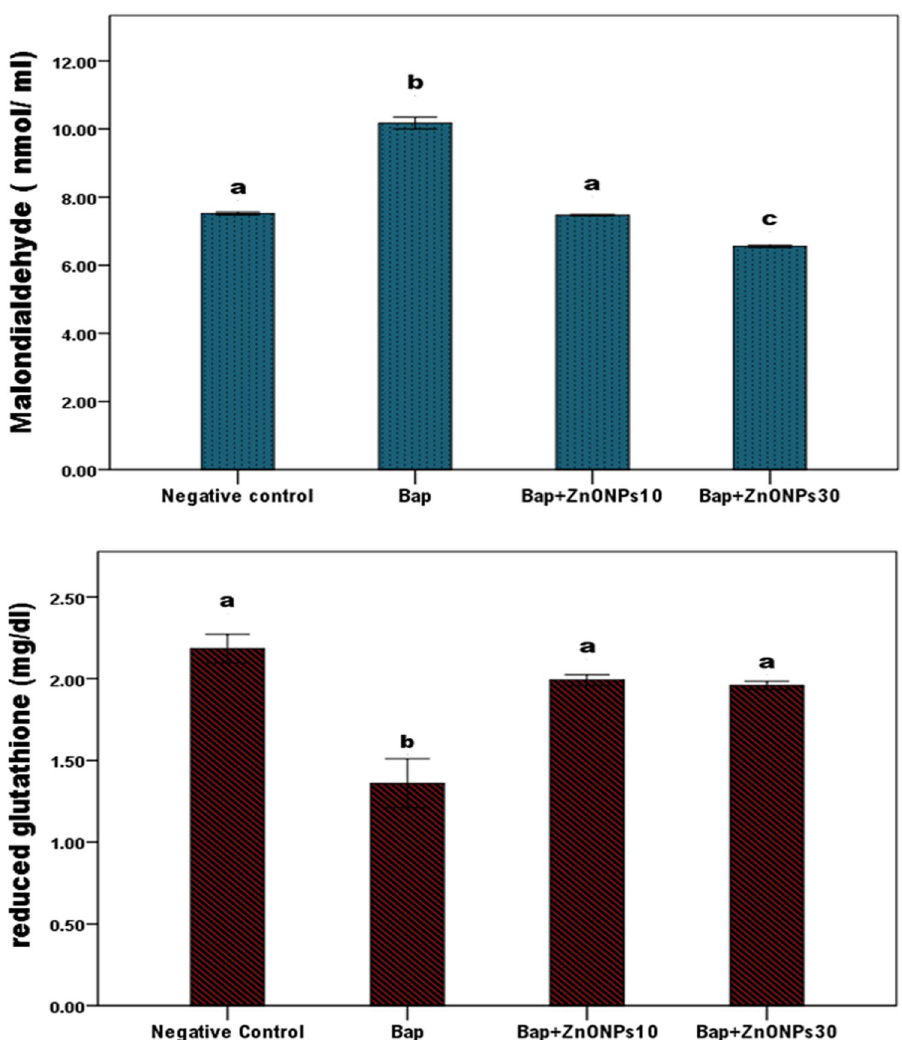
Figure 3. Antioxidant effect of zinc oxide nanoparticles (ZnO NPs) in benzo[a]pyrene (B[a]P)-challenged rats. The B[a]P group showed a significantly increased serum level of malondialdehyde (MDA) accompanied by a significant decrease in the level of reduced glutathione (GSH) compared with the negative control. The co-administration of B[a]P with ZnO NPs resulted in the significant decrease in MDA and an increase in the serum level of GSH, counteracting the effect of B[a]P and ultimately restoring the enzymes’ normal levels, especially GSH.Means with different superscripts (a, b, and c) indicate a significant difference at P <